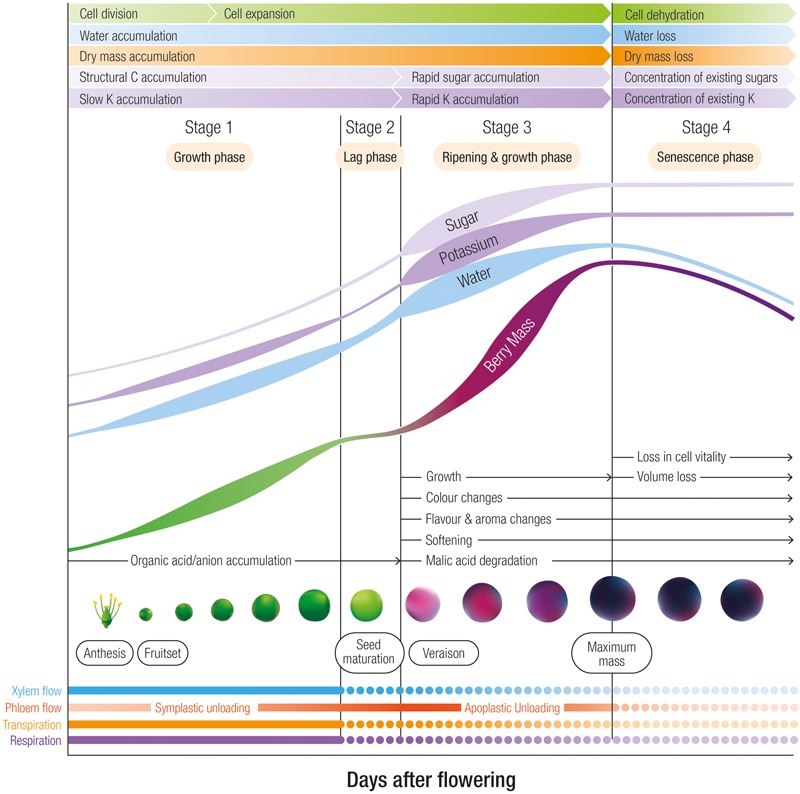
The four developmental stages of grape berries designating phases of rapid sugar, potassium and water accumulation. In Shiraz berries grown in a warm viticulture region of Australia, the lag phase occurs between 45 and 55 days after flowering, and maximum weight occurs at approximately 90 days after flowering. Stage 3 is associated with ripening and includes color, flavor and aroma changes, softening and malic acid degradation. Relative changes in cell division, cell expansion, dry mass, structural carbon accumulation, xylem and phloem flow, transpiration and respiration are also indicated.